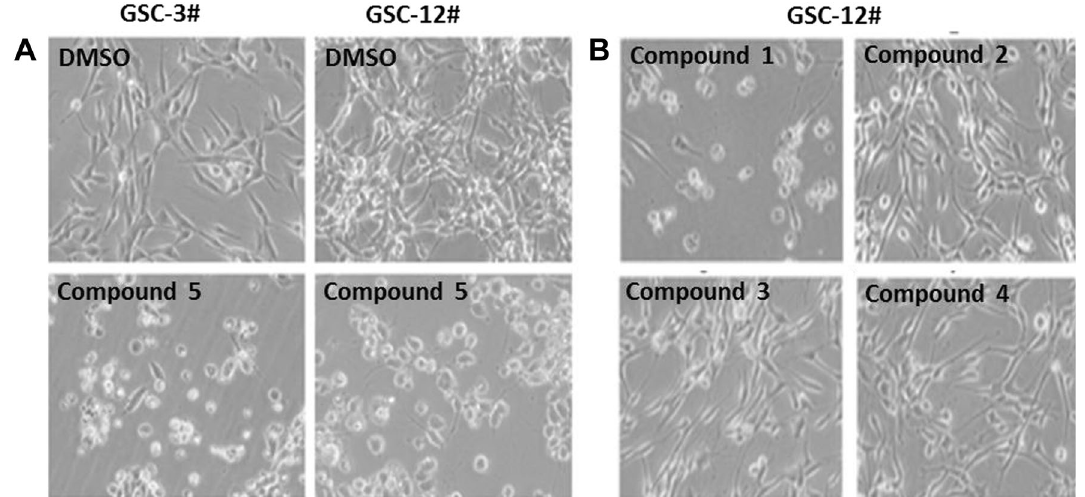
Fig. 4 Compounds 1 – 5 against human glioma stem cells by phenotypic screening; a Compound 5 against GSC-3# and GSC-12# at 10 l g/mL; b Compounds 1 – 4 against GSC-12# at 25 l g/mL